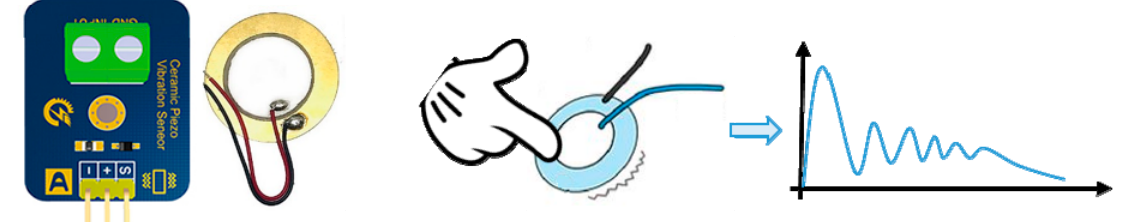
Figure 3. The analog piezoelectric ceramic shock sensor.